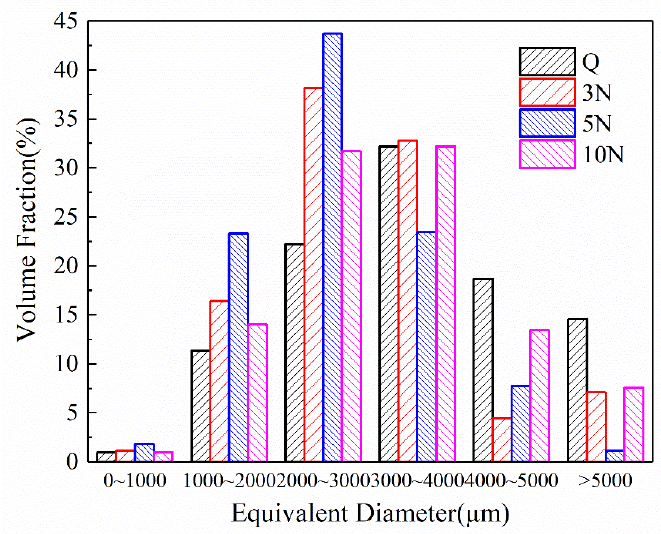
Figure 13. Equivalent diameter pores of concrete with different content of sodium sulfate on the 28th